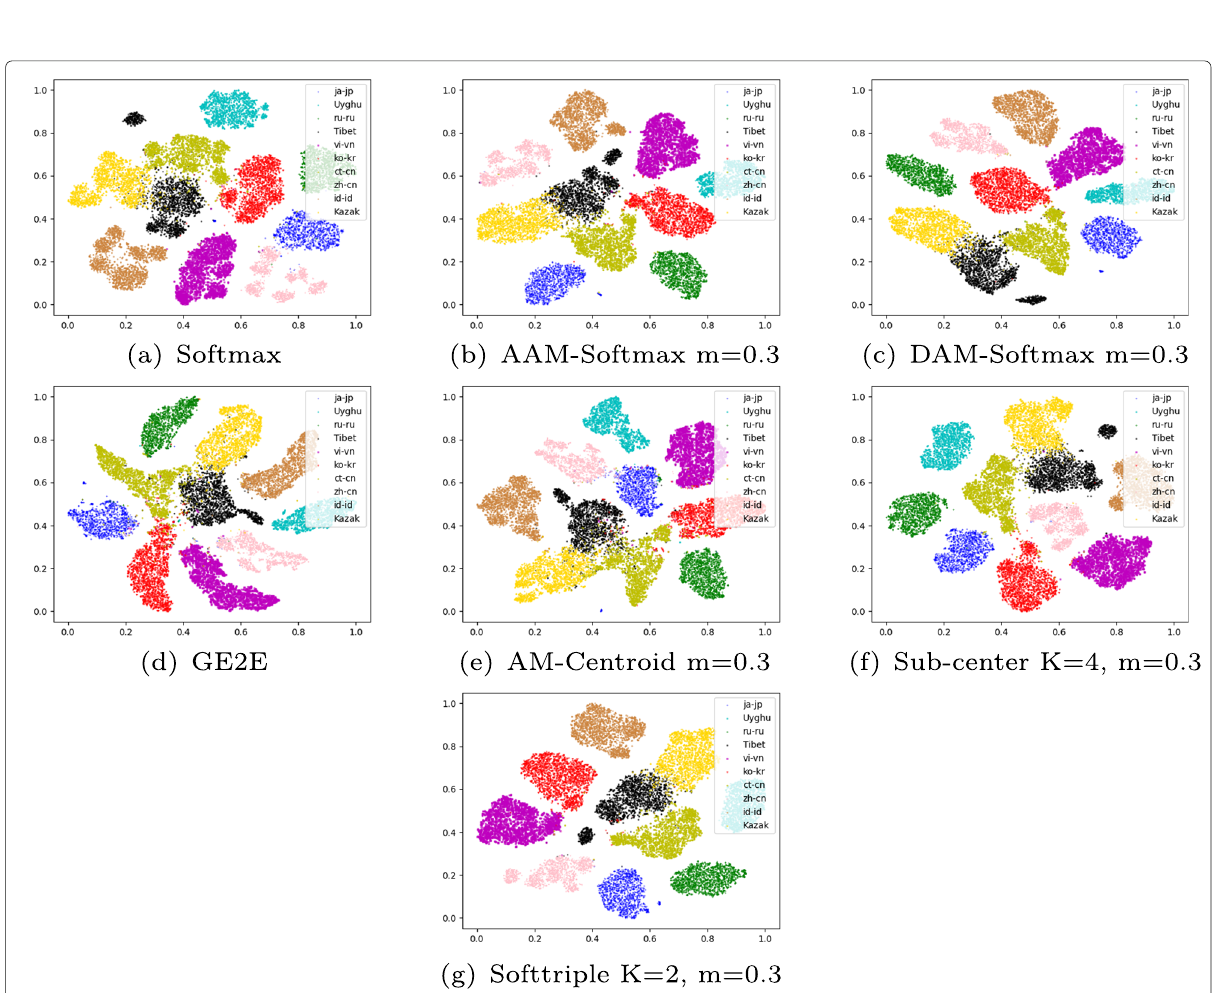
Fig. 10 Language embeddings of the baselines are plotted by t-SNE, under test-all on AP17-OLR. Each shape/color represents a different language. a EER=4.15, C avg =3.89, min DCF=3.92. b EER=1.83, C avg =1.79, min DCF=1.92. c EER=2.16, C avg =1.98, min DCF=2.01. d EER=3.60, C avg =3.51, min DCF=3.61. e EER=3.43, C avg =3.26, min DCF=3.33. f EER=2.02, C avg =1.84, min DCF=2.12. g EER=2.03, C avg =1.87, min